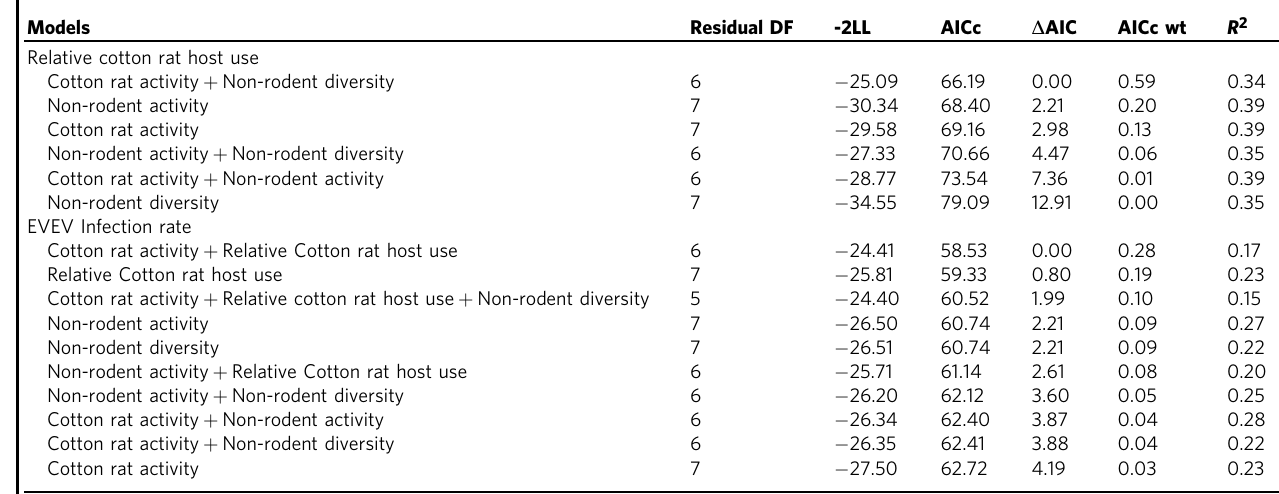
Table 1 Rankings of models used to explain the variation in the mammal community, host use, and Everglades virus (EVEV) infection rate in the vector.